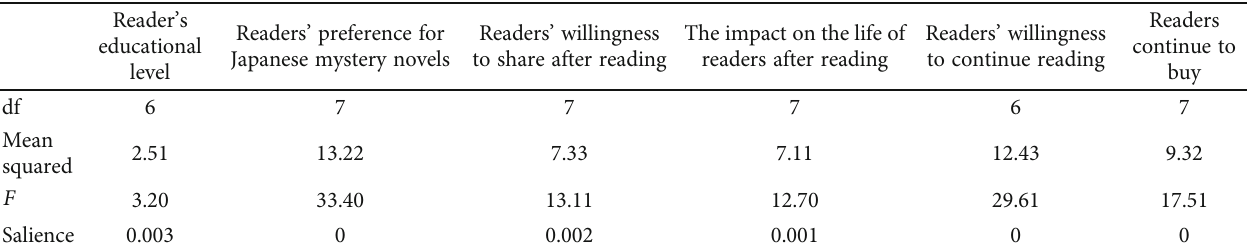
Table 4: Analysis of variance table of readers ’ emotions, behaviors, and enjoyment of reading Japanese